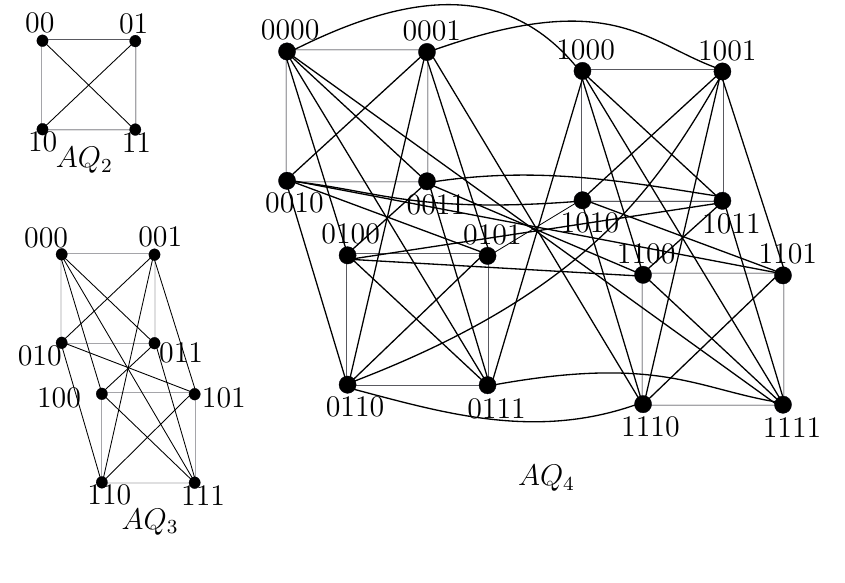
Figure 1: Augmented cube AQ